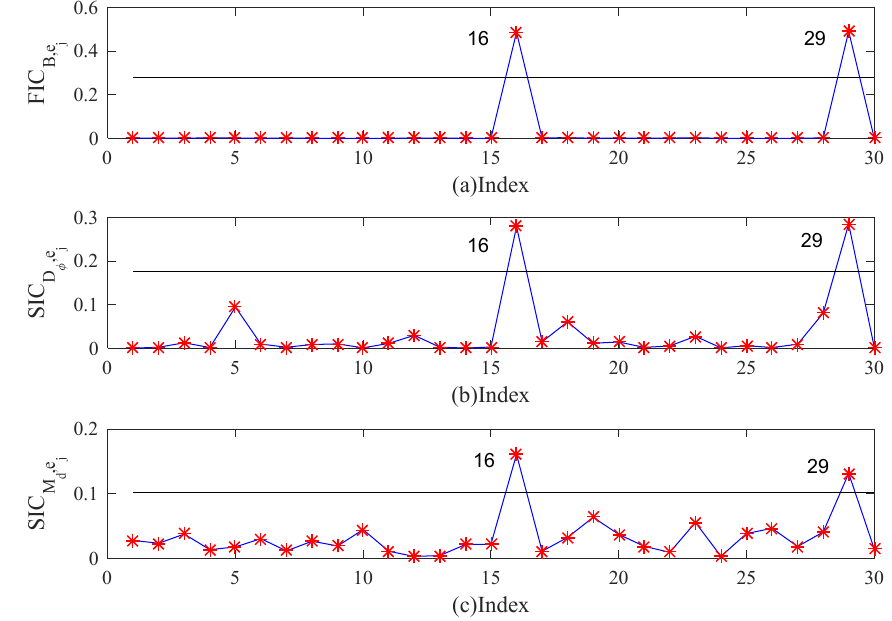
Figure 1. Plots of covariate perturbation in Simulation 1.